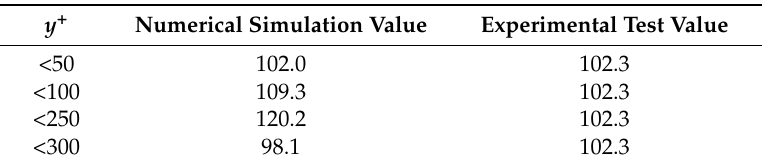
Table 2. Comparison of the resistance.